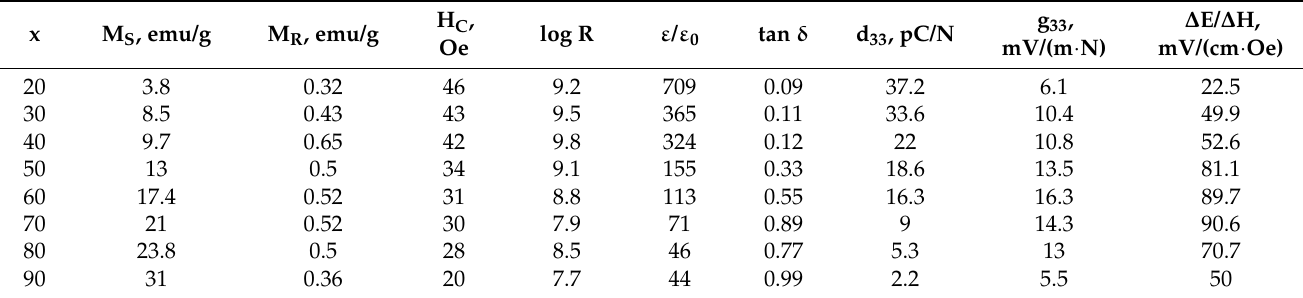
Figure 4. Magnetic hysteresis loops of (100 − x) wt.% BCZT + x wt.% NCCMF composite ceramics. Table 1. Properties of ME composite ceramics (100 x) wt.% BCZT + x wt.%